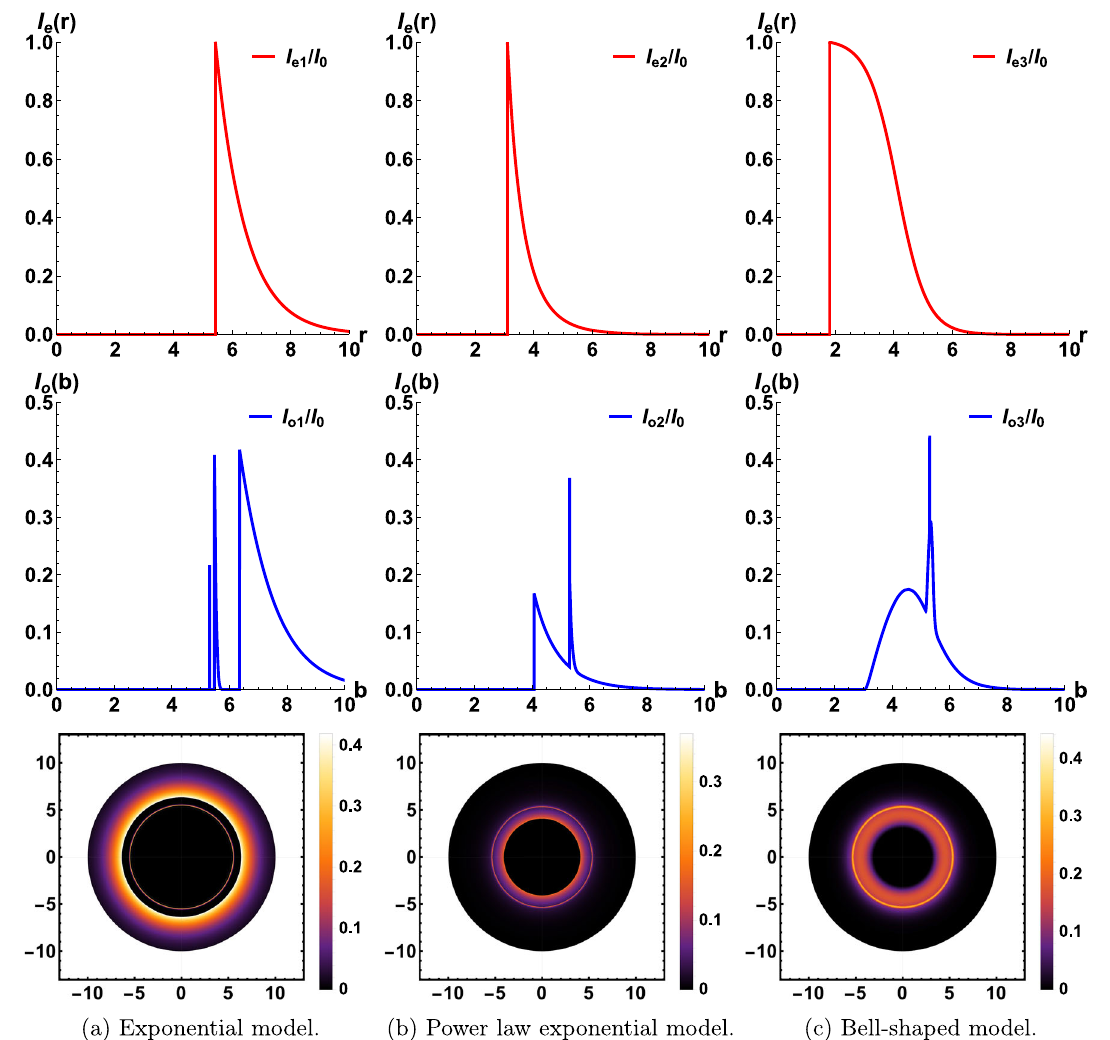
Fig. 15 Observational appearances of a thin disk for different models with fixed β = 0 . 2 and P = 0 . 6. The first row shows the emissive functions I e ( r ) , and the figures in the second row are the observed intensities I o ( b ) . In the third row, we plot these observed intensities into two-dimensional